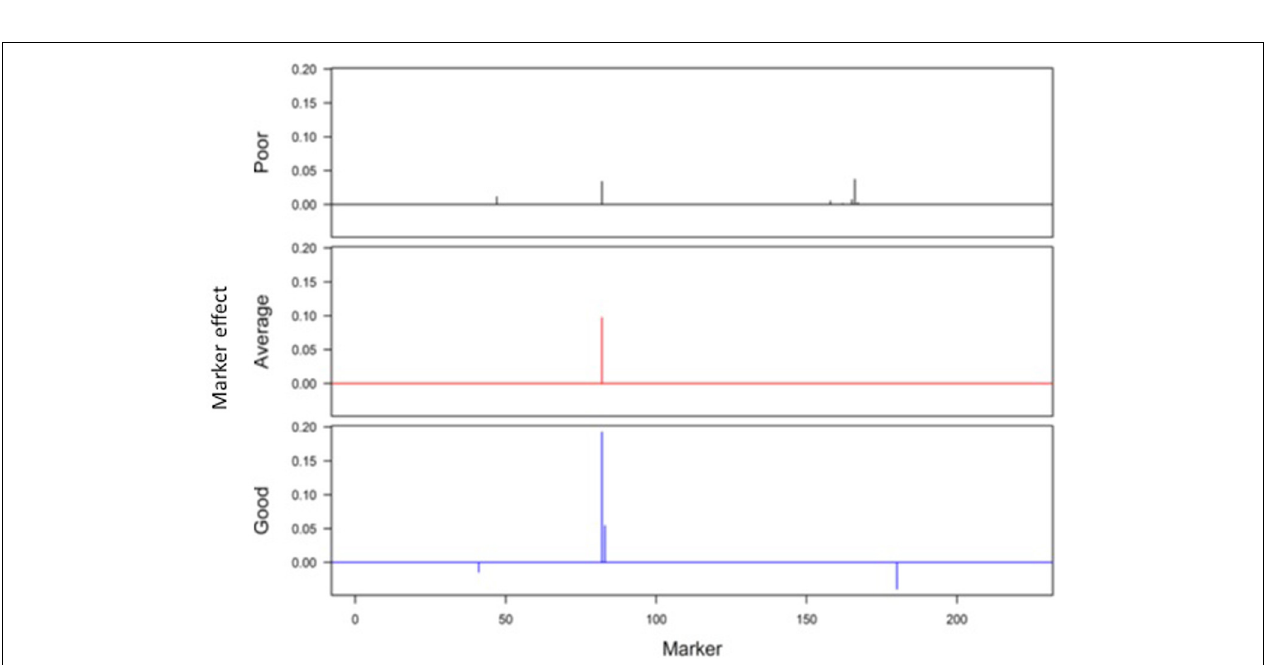
FIGURE 4 | Genome-wide scan of QTLs responsible for barley yield in poor, average, and good environments using the LASSO analysis.